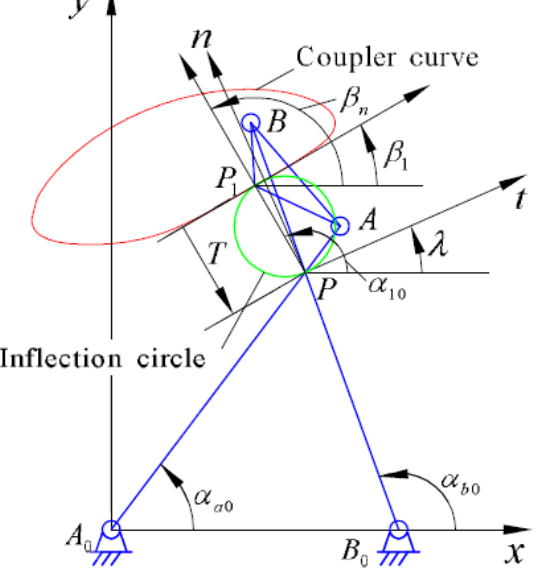
Figure 1. Definitions of various parameters (Yin et al.,